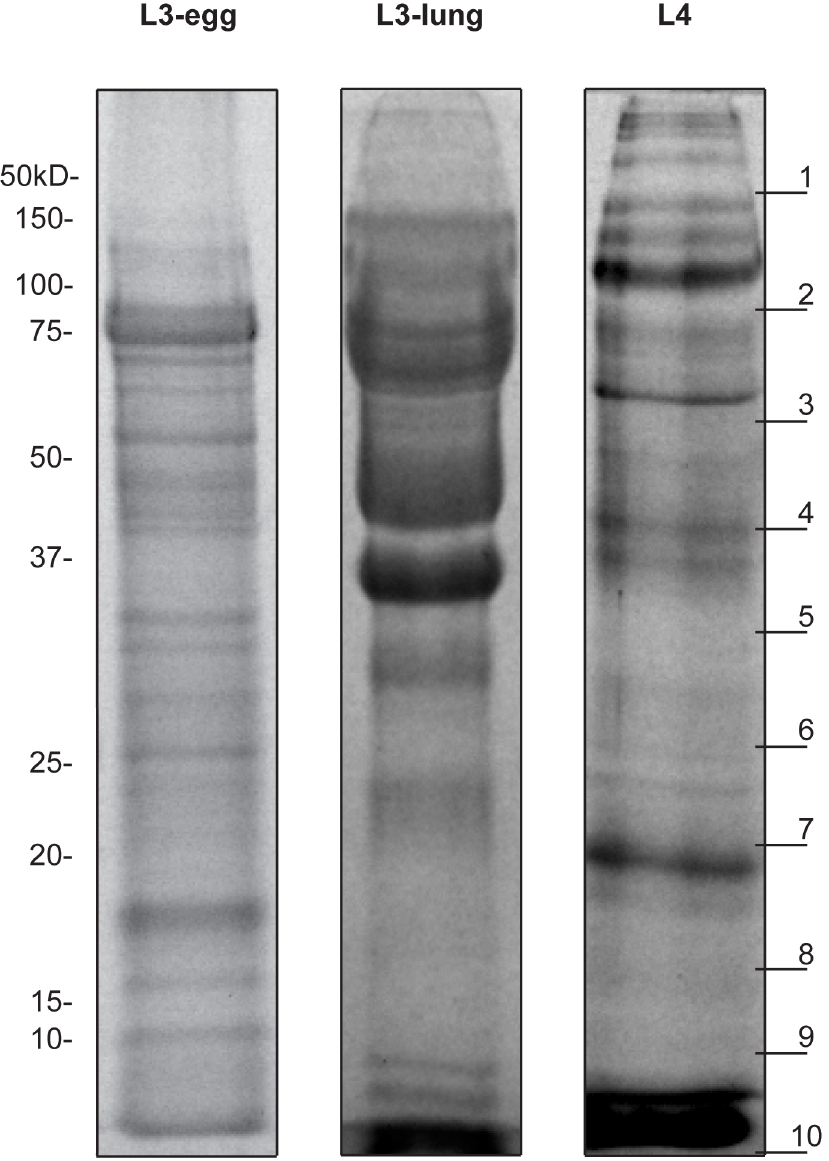
Figure 1. Protein profile of the A.suum ES products. Protein profile of the A. suum L3-egg, L3-lung and L4 ES products displayed on a 12% SDS- PAGE stained with Coomassie blue. Each lane was loaded with 15 m g of protein. Molecular weight markers are indicated to the left. The 10 gel slices used in the trypsin digests are indicated on the right.